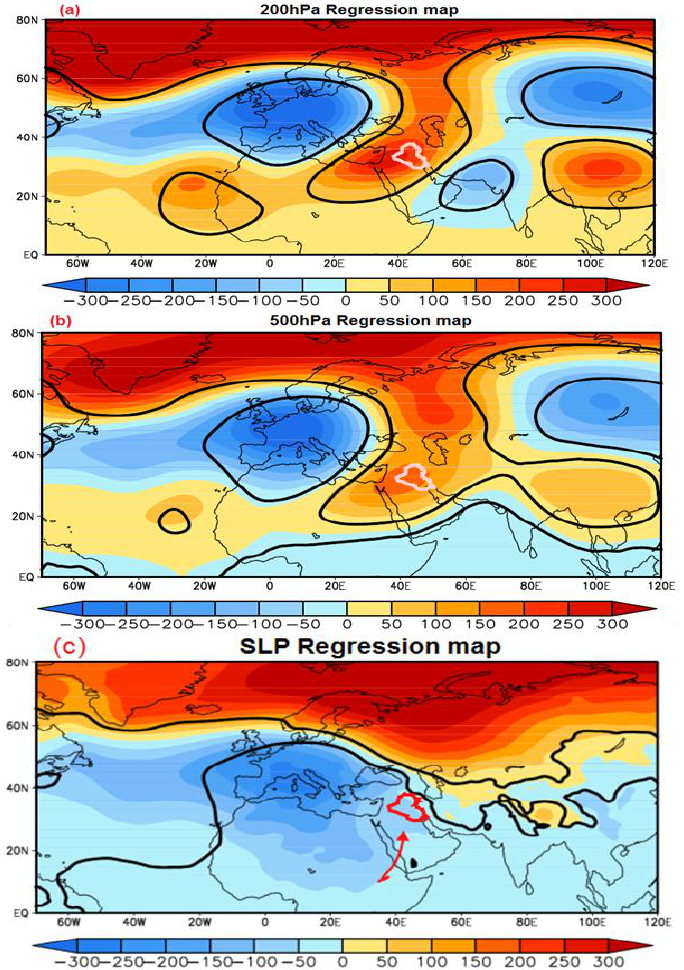
Figure 7. Regression maps of winter ( a ) geopotential height 200 hPa, ( b ) 500 hPa and ( c ) SLP fields on the time series of Indian Ocean SLP associated to the first pair derived through CCA (Fig. 6b), for the 1979 – 2016 period. The red contour lines in panels (a, b and c) mark the border of Iraq. The thick red arrow in panel (c) is used to explain the air advection. The black contour lines in panels (a, b and c) represent the 95% confidence level of the statistical significance of the regression.